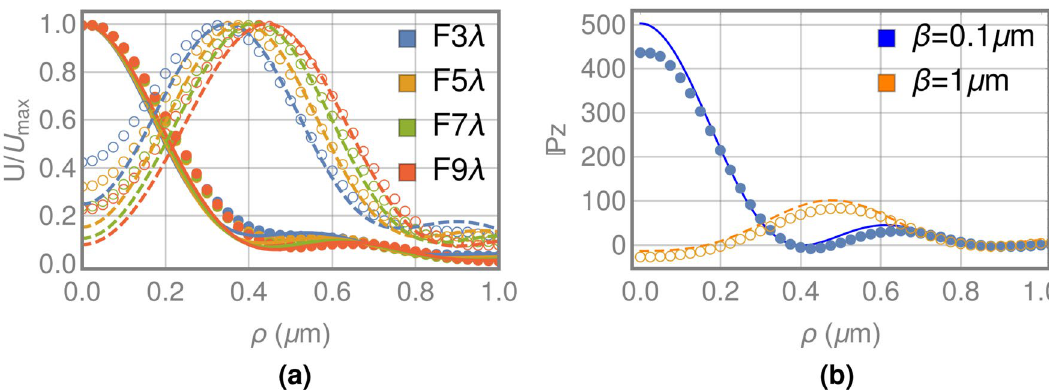
Figure 3. ( a ) Normalized electromagnetic energy in the focal plane for SGFZPs (continuous lines and filled circles) and LGFZPs (dashed lines and unfilled circles) with different focal lengths estimated through the proposed model (lines) and FDTD (circles). ( b ) Axial component of the Poynting vector in the focal plane for a SGFZP (continuous line and filled circles) and a LGFZP (dashed line and unfilled circles) with focal length of 7 (cid:31) estimated through the proposed model (lines) and FDTD